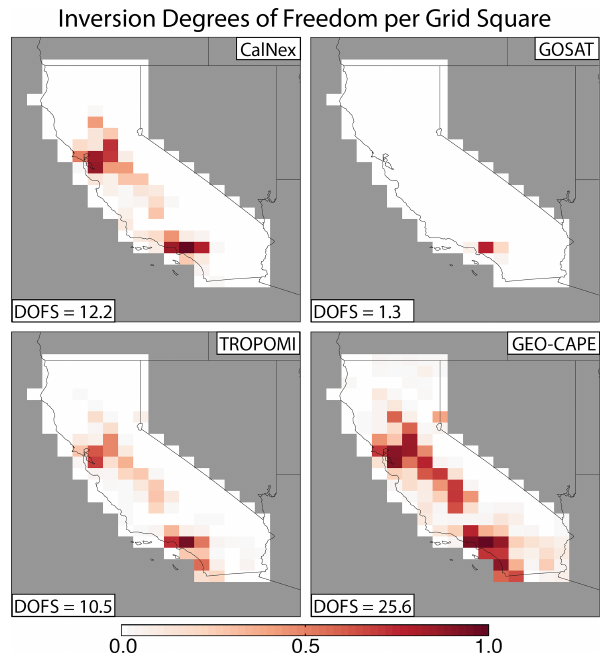
Figure 4. Degrees of freedom in each grid square from our inver- sions using CalNex (top left) and GOSAT (top right) observations and from our observation system simulation experiments (OSSEs) using TROPOMI (bottom left) and GEO-CAPE (bottom right) syn- thetic observations. Values are the diagonal elements of the aver- aging kernel matrix for the inversion and represent the ability of the observations to constrain local emissions (see text). The sum of these degrees of freedom (trace of the average kernel matrix) rep- resents the degrees of freedom for signal (DOFS) of the inversions, inset. Gray grid squares are excluded from the